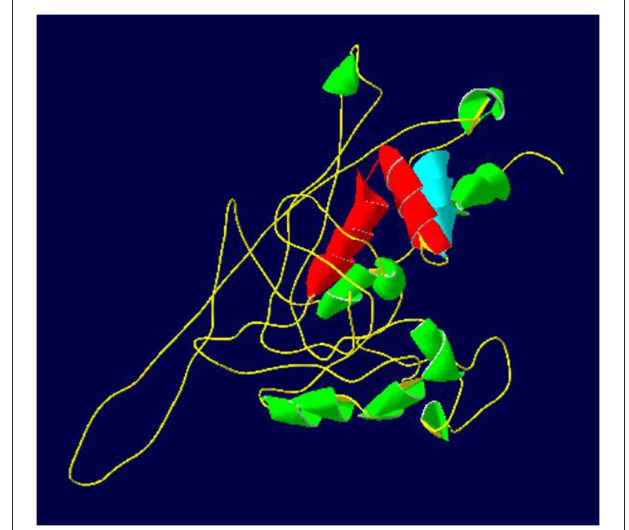
FIGURE 2 | Predicted tertiary structure of 1R-MYB TF from chickpea. The repeat (helix-helix-turn-helix structure) and the MYB domain are represented by the blue and red (helix-turn-helix). The highlighted MYB domain region has been predicted based on the 1R-MYB TF from Solanum tuberosum . C score for structure: –2.72. The green color represents other helices that are not a part of the MYB domain.